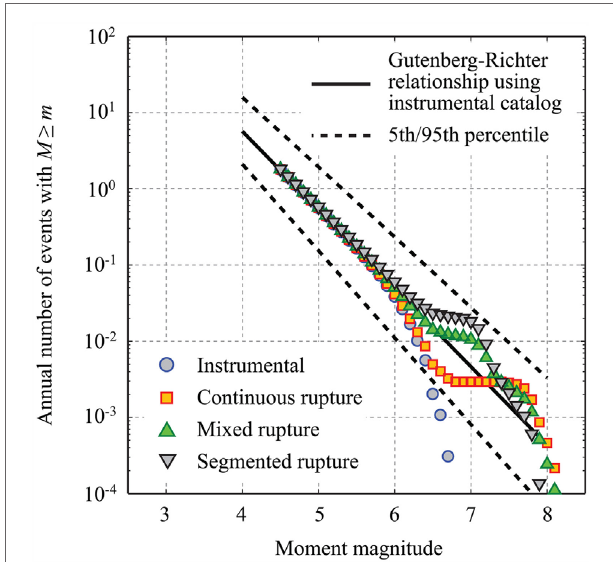
FigUre 5 | gutenberg–richter relationships for the instrumental catalog-based model, continuous rupture model, mixed rupture model, and segmented rupture model [modified from hodge et al. (2015)]